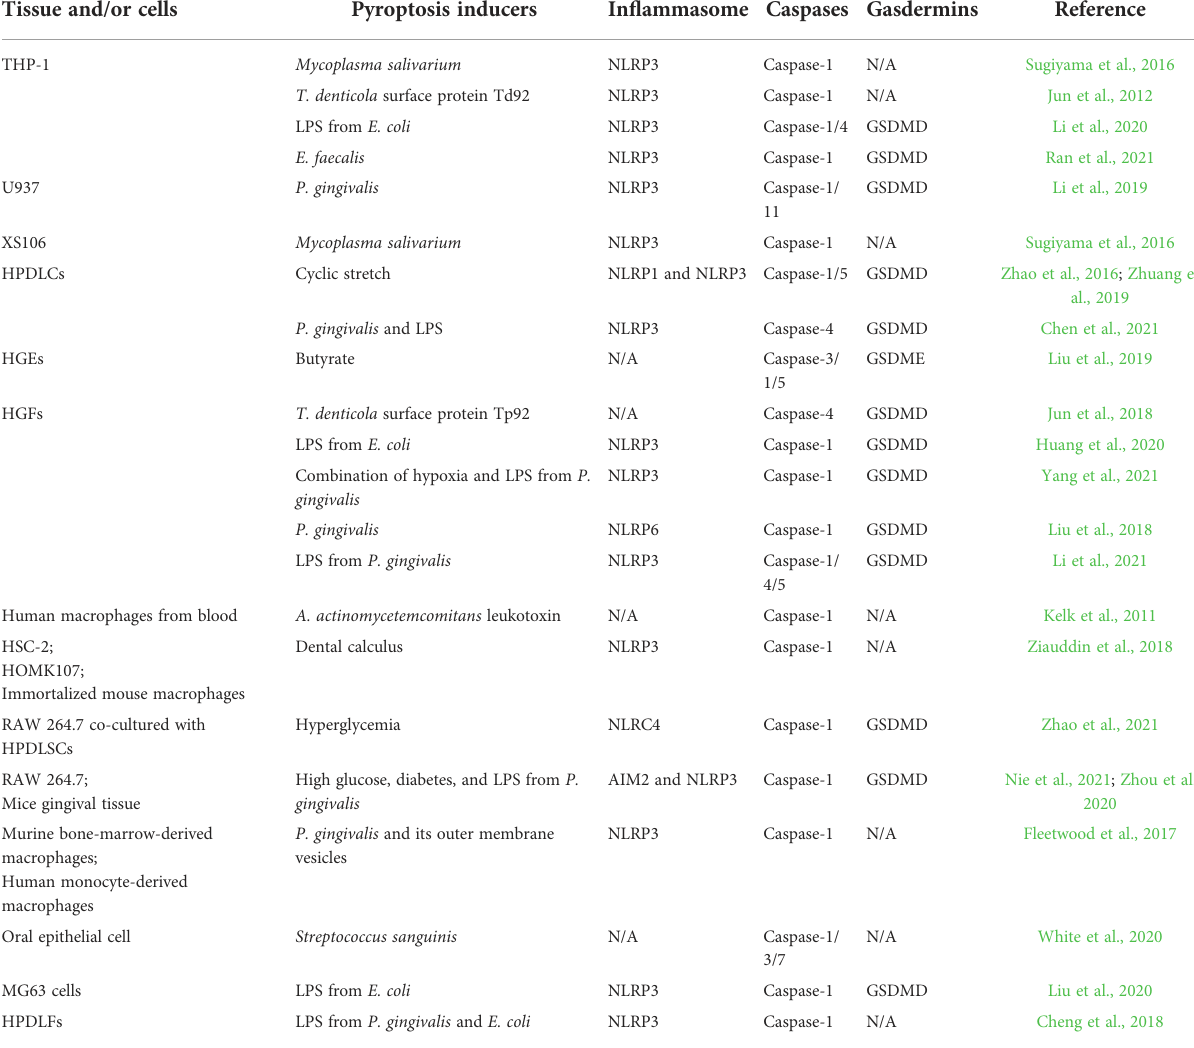
TABLE 1 Reported periodontal pathogenic factors in the activation of pyroptosis-related caspases and gasdermins. Tissue and/or